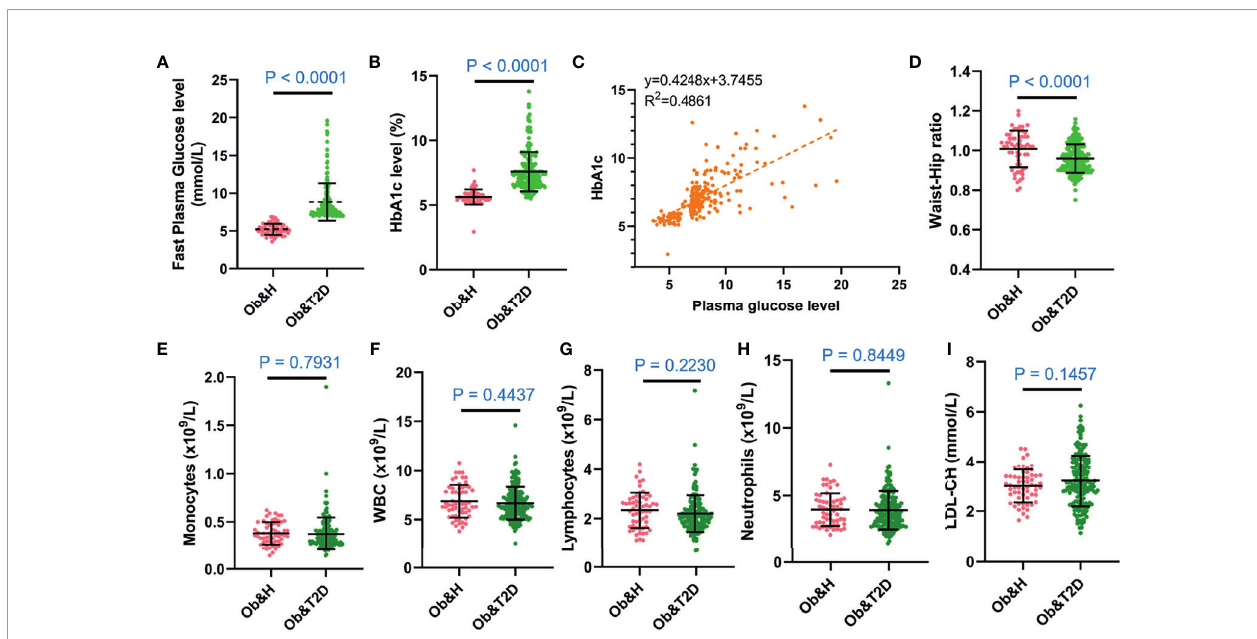
FIGURE 1 | The overall characteristics of the study participants. (A, B) Dot plots display the fasting plasma glucose (A) and HbA1c levels (B) of the study participants. (C) Correlation between capillary plasma glucose level and HbA1c level. (D) Waist-to-hip ratio of the study participants. (E – I) In fl ammation-related indices of the study participants: monocytes (E) , white blood cell (F) , lymphocytes (G) , neutrophils (H) , and low-density lipoprotein (I) . Ob&H, obese and healthy; Ob&T2D, obese and type 2 diabetes. Data are shown as means ± SD. All P -values were from Wilcoxon rank-sum